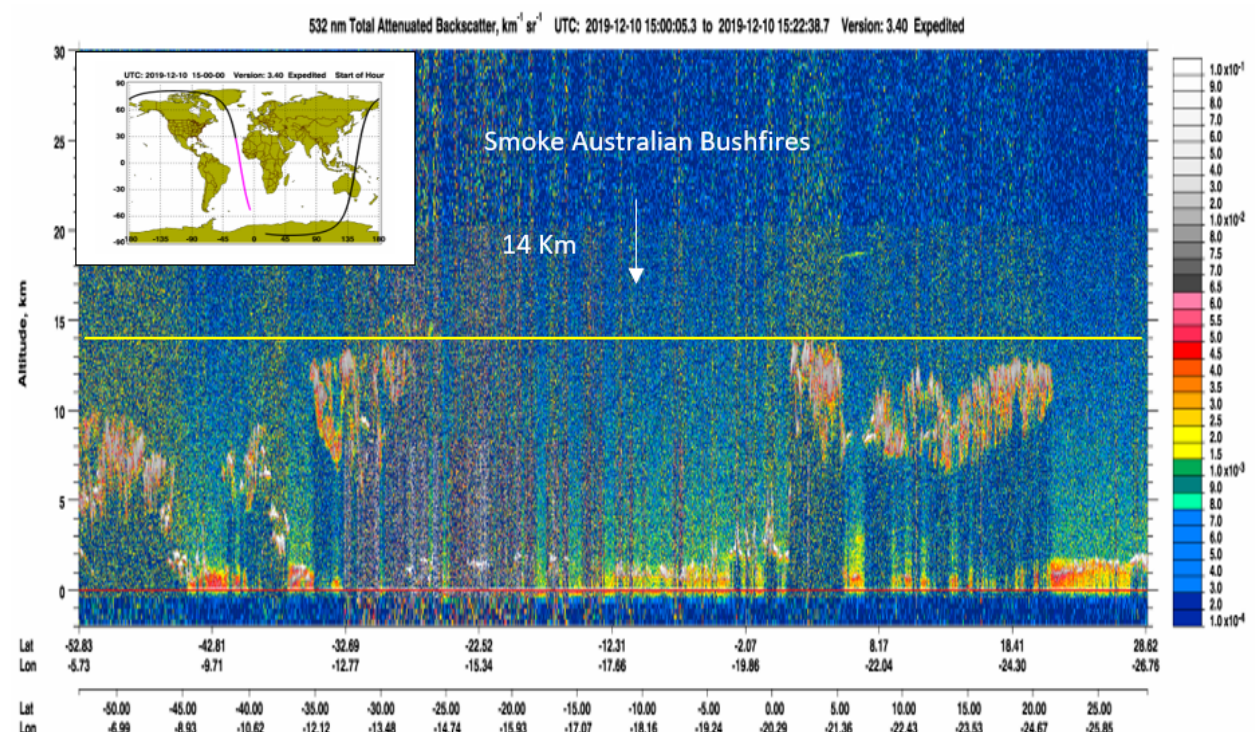
Figure 7. Aerosols measured during the CALIOP daytime transect (inset from [ − 52.83, − 5.73] to [28.75, 26.80]) on 10 December 2019 showing the 532 nm total attenuated backscatter that can distinguish the presence of smoke in the atmosphere.